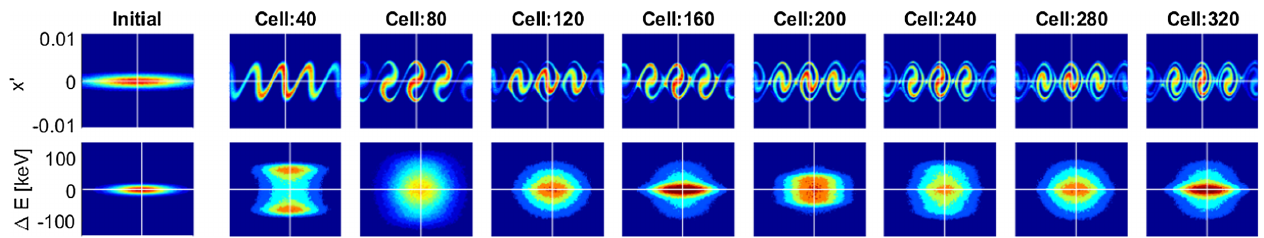
0 . The axes are − 1 . 5 μ m < x < 1 . 5 μ m and y ¼